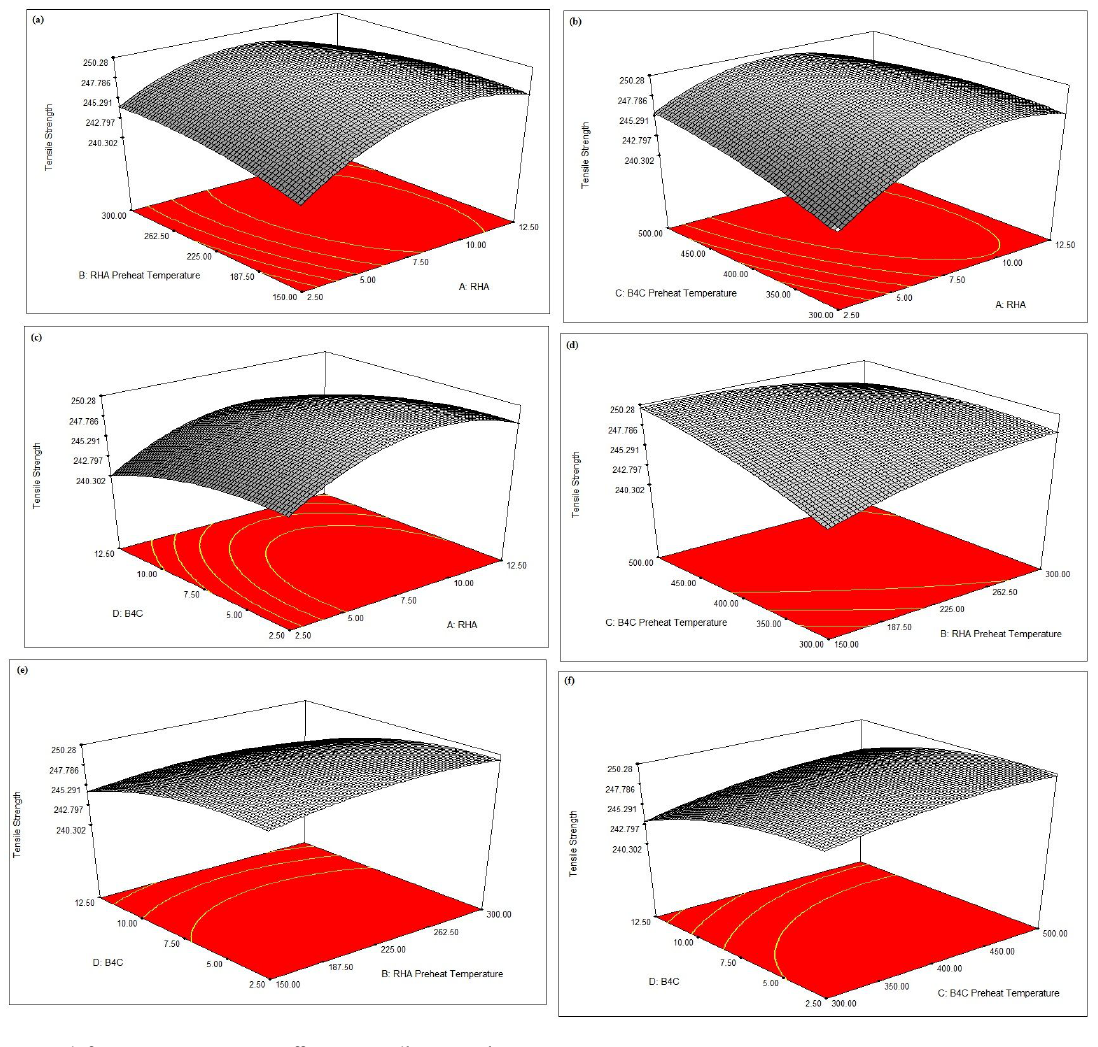
Figure 8: 3D reinforcement parameters effect on tensile strength